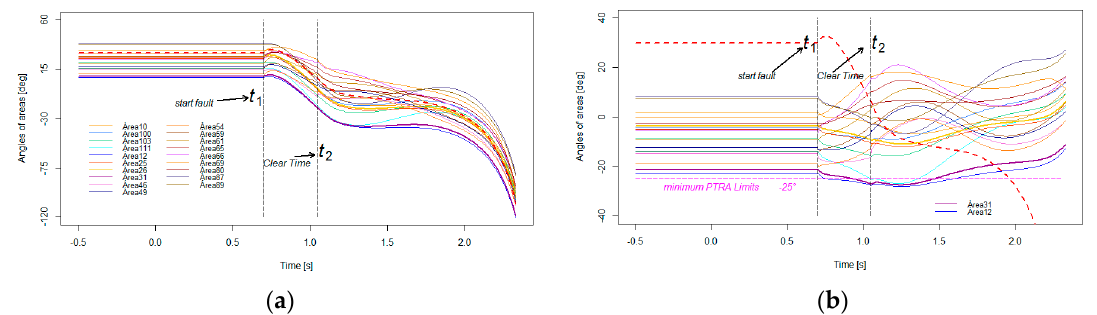
Figure 11. Angles measured in the generation buses of the IEEE 118-bus power system after a three-phase fault in Line 49-66C1 with clearing time at 0.350 ms. ( a ) Voltage angles and ( b ) relative angles.